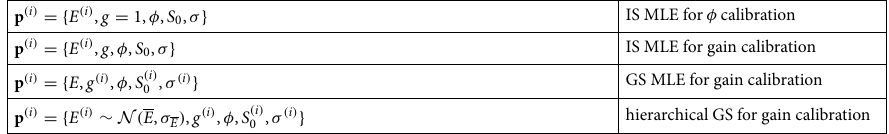
Table 2. Parameter sets for MLE. Shared and unique parameters for the multiple dataset likelihood-based calculations. IS and GS MLE methods use different combinations of shared parameters to group datasets.